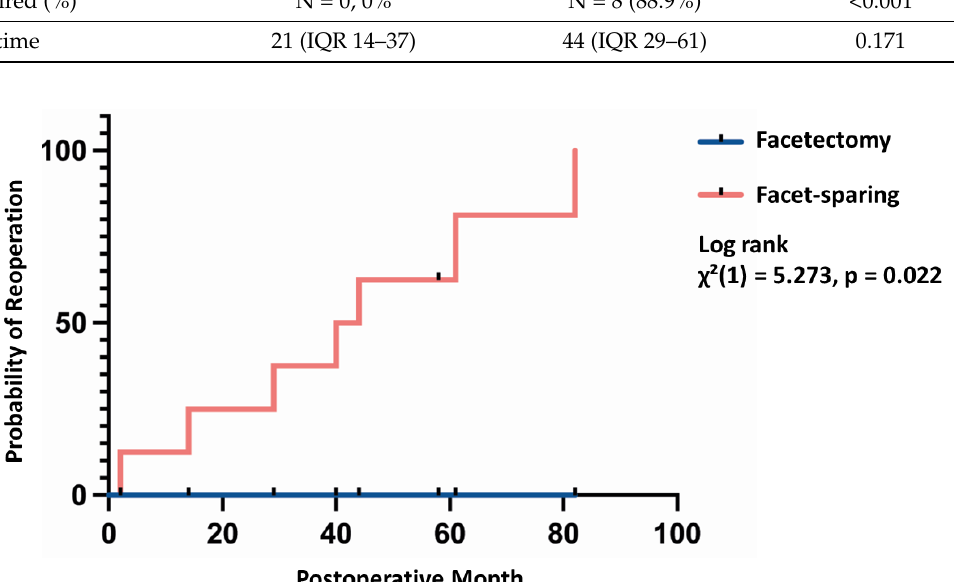
Figure 3. Cumulative risk of reoperation over time for patients with lumbar dumbbell tumors. Blue line indicates patients in the facetectomy group (N = 10, median follow up 21 months (IQR 14–37) and the red line patients in the facet-sparing group (N = 9, median follow up 44 moths (IQR 29–61). Log rank Meier-Kaplan analysis shows a higher risk of reoperation in the facet-sparing group ( p = 0.022).